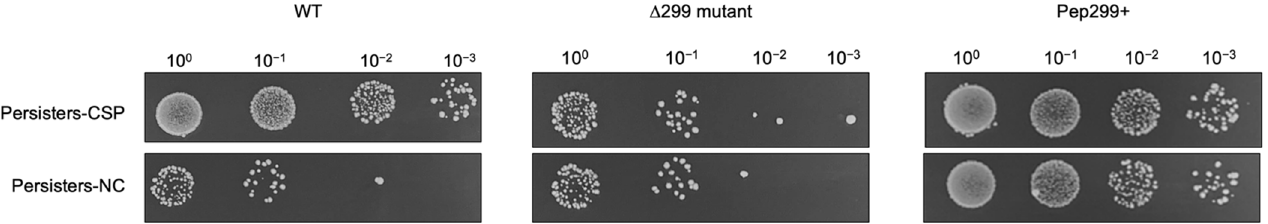
Figure 2. Formation of S. mutans antibiotic persisters. Cultures of wild-type (WT), Δ 299 mutant, and Δ 299-overexpressing mutant (Pep299+) were incubated with CSP (‘persisters-CSP’) or without CSP (‘persisters-NC’) before being treated with ofloxacin antibiotic to kill all nonpersisters (see Methods for details). Cells were washed with PBS, serially diluted (10 0 ; 10 − 1 ; 10 − 2 ; 10 − 3 ), and spot-plated onto THYE agar. Pictures shown are representative of three independent experiments.